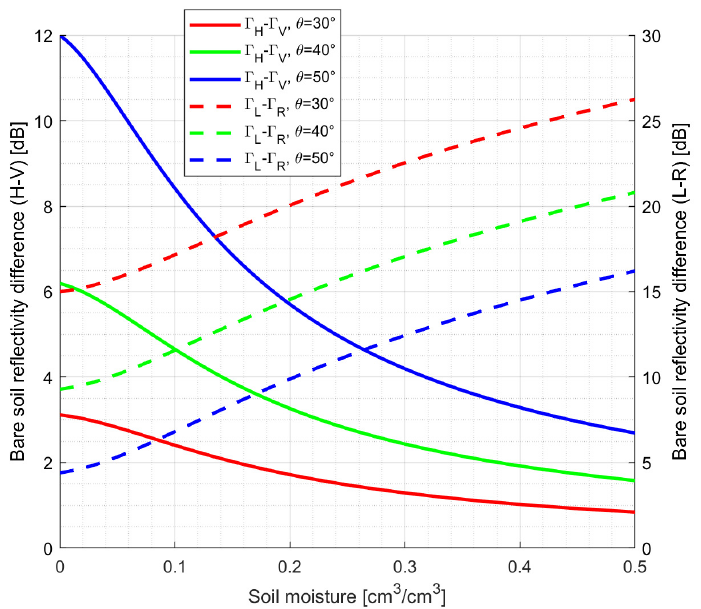
Figure 8. Soil moisture and bare soil re fl ectivity di ff erences between two orthogonal polarizations as a function of the incidence angle, simulated from a soil composition of Sand = 40%, Clay = 20%, and Silt = 60% [30].